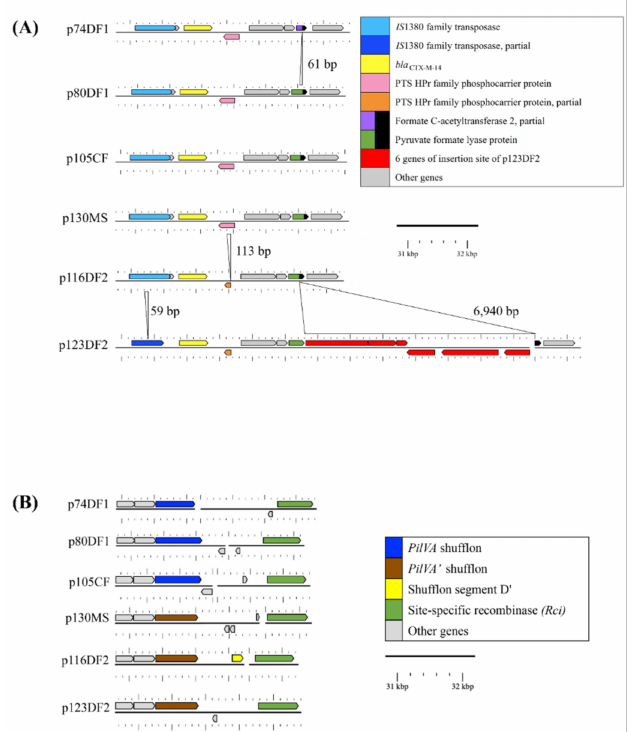
Figure 4. The difference in two regions located around ( A ) bla CTX-M-14 (7334 bp) and ( B ) within